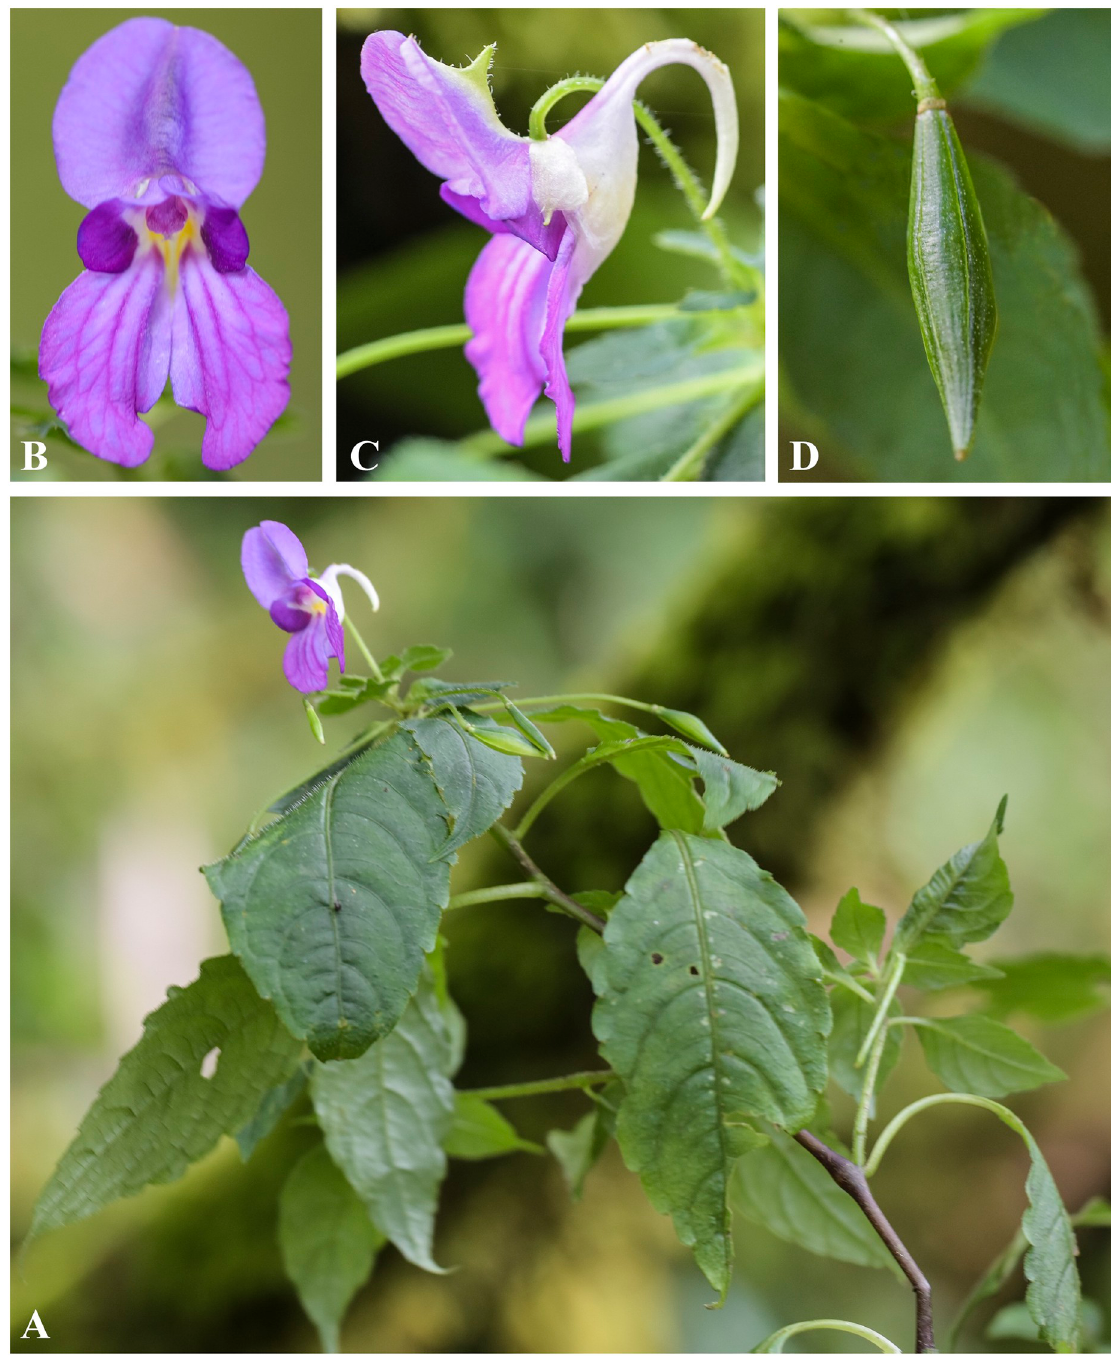
Fig 20. Impatiens puberula A. Flowering plant; B. Flower (front view); C. Flower (side view); D. Capsule. Photographs by Bhakta Bahadur Raskoti.